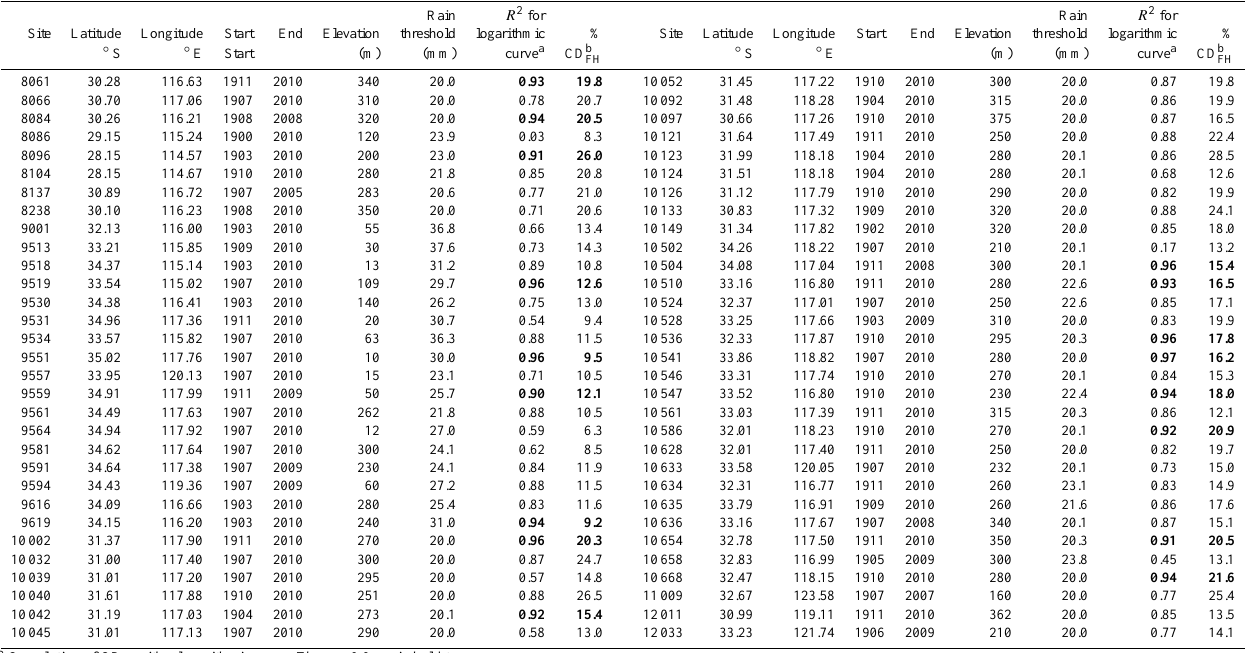
Table 3. Southwest group of rainfall